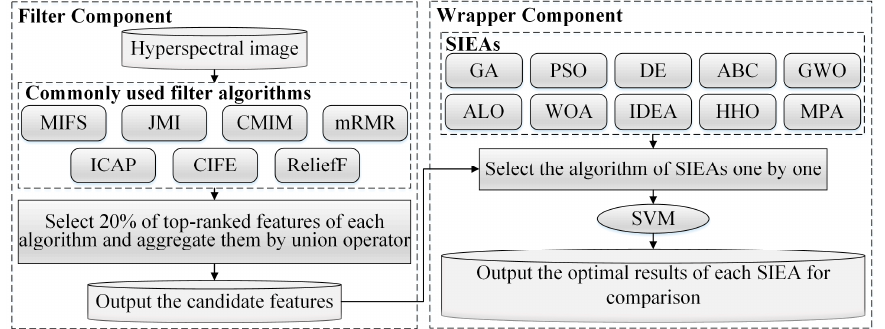
Figure 1. Flowchart of the filter–wrapper framework. The framework includes the filter and the wrapper components.